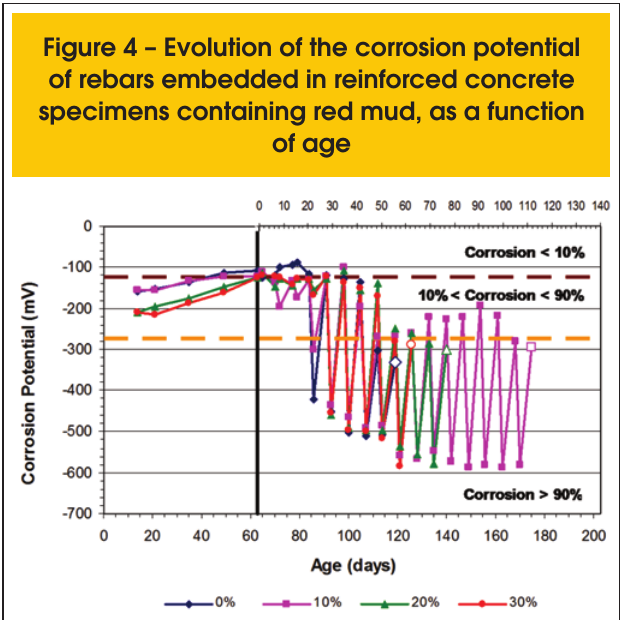
Figure 6 – Corrosion rate of steel bars embedded in reinforced concrete specimens,